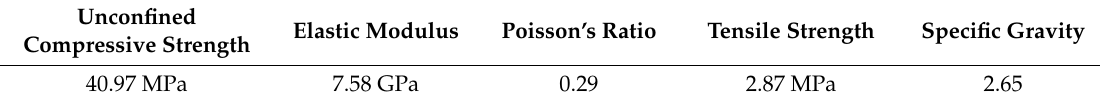
Table 4. Physical characteristics for numerical